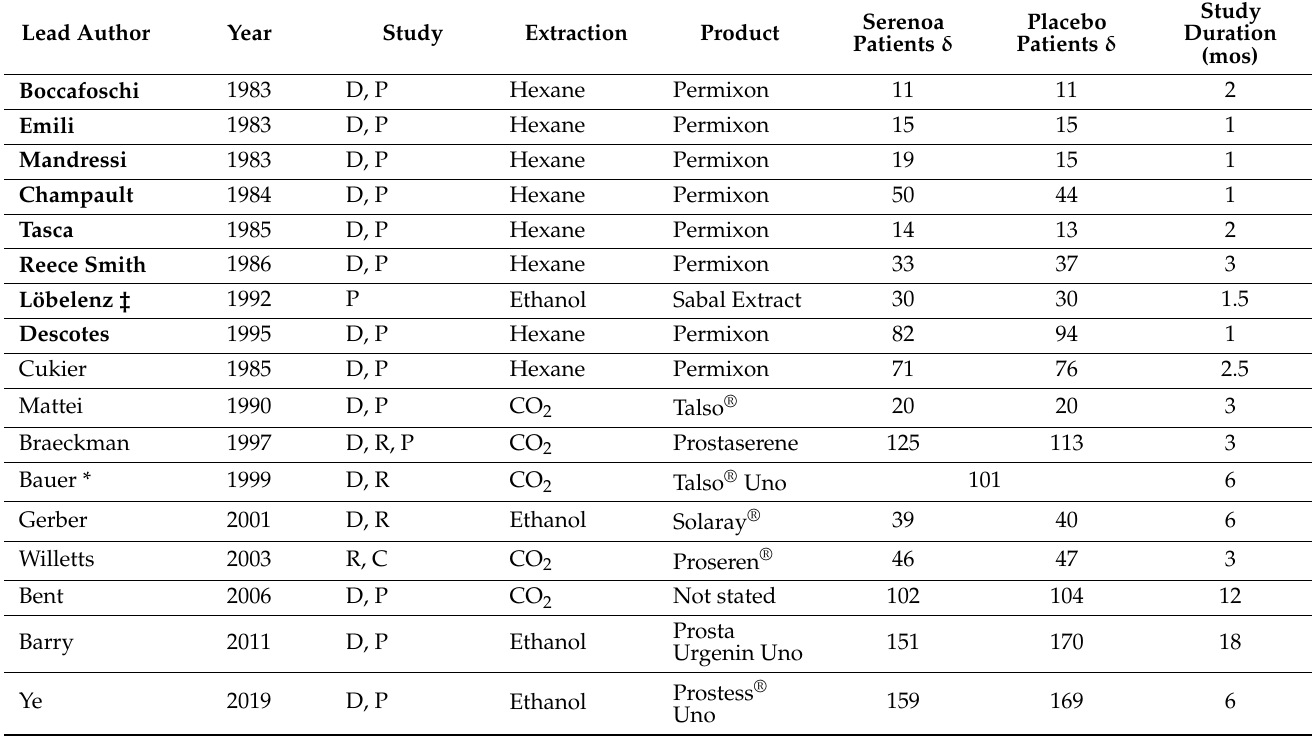
Table 8. Summary of 17 placebo-controlled LSESr clinical trials. Eight studies (bolded) did not meet our criteria for evaluability for LSESr vs. LUTS/BPH.